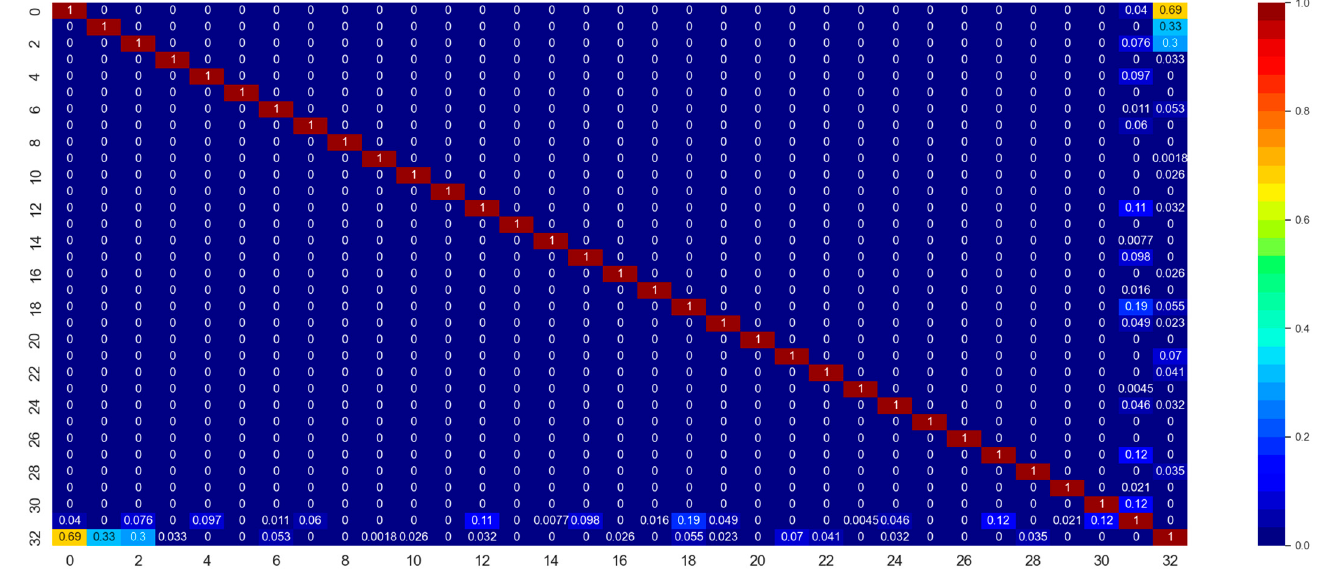
Figure 9. Explained variance ratio for 32 principal components.